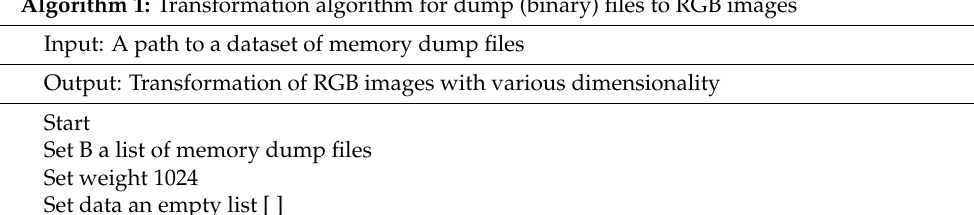
Table 3. Pseudocode of an algorithm used for the transformation of dump (binary) files into images. Algorithm 1: Transformation algorithm for dump (binary) files to RGB images